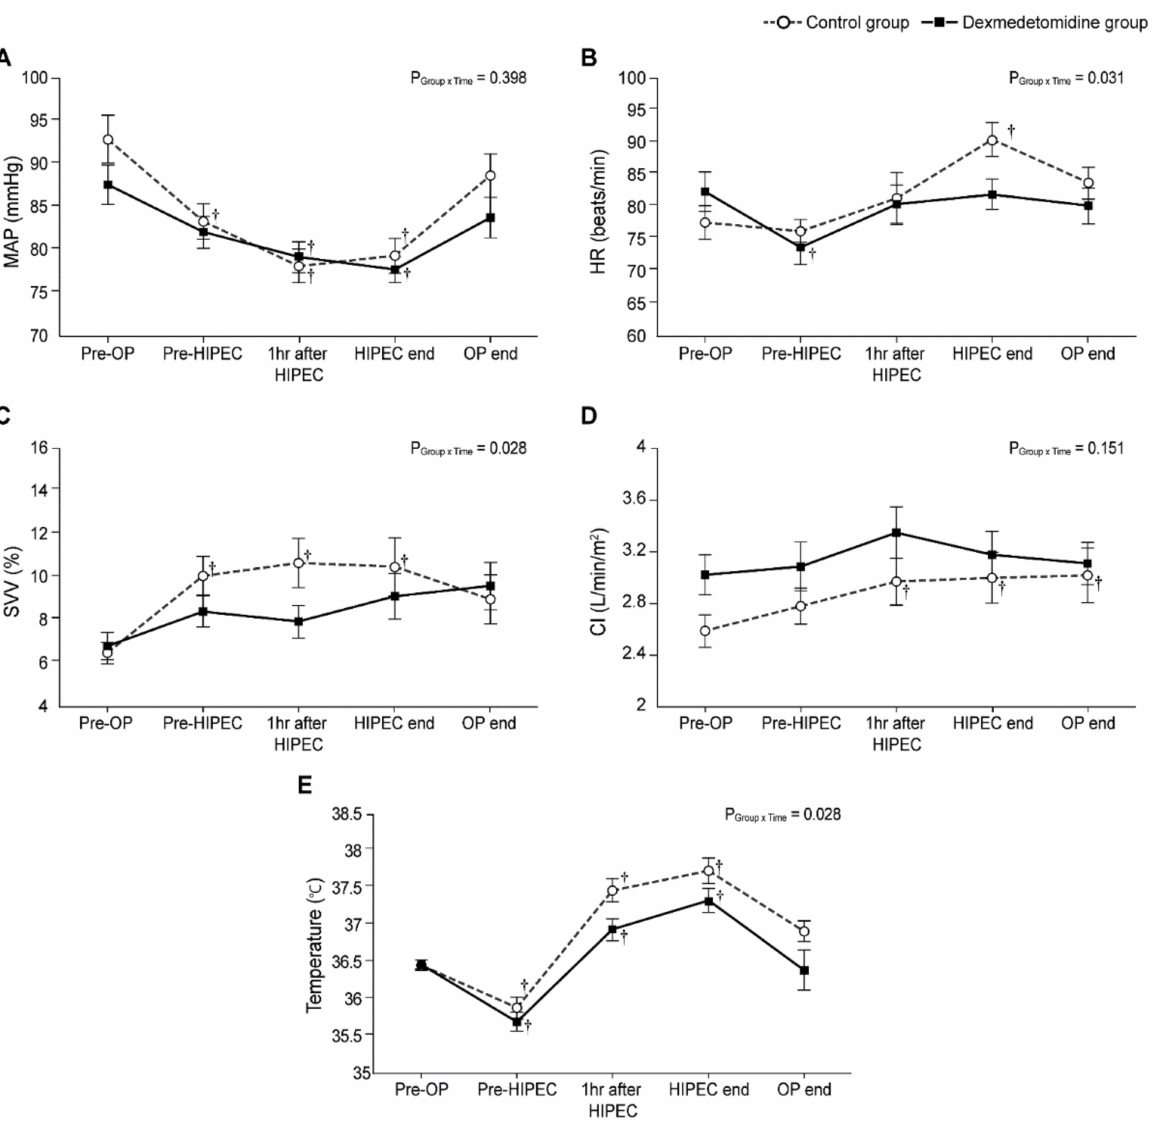
Figure 4. Intraoperative changes in ( A ) mean arterial pressure (MAP), ( B ) heart rate (HR), ( C ) stroke volume variation (SVV), ( D ) cardiac index (CI), and ( E ) temperature. Pre-OP, pre-operation; Pre-HIPEC, before the initiation of HIPEC; HIPEC end, immediately after the end of HIPEC; OP end, after the end of the operation; POD, postoperative day. Values are shown as mean ± standard deviation. † Bonferroni-corrected p < 0.05 versus Pre-OP in each